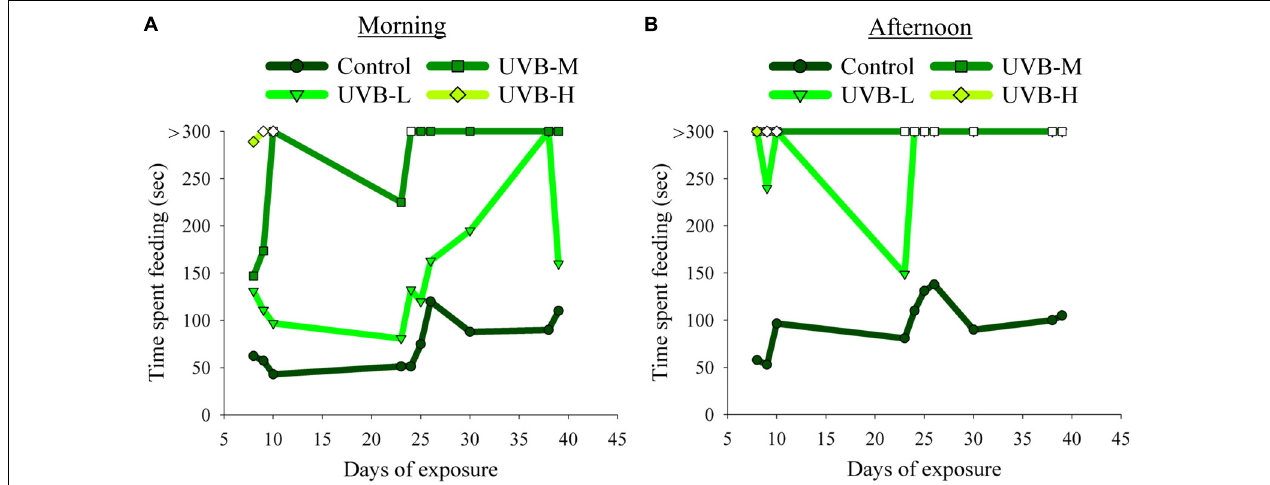
FIGURE 2 | Effect of UVB on the S. aurata feeding behavior observed during the experimental time: (A) morning (1 h before starting the UVB exposure) and (B) afternoon (4 h after starting the UVB exposure) meals. The time spent to consume the food (seconds, sec) was recorded on the 8th, 9th, 10th, 23rd, 24th, 25th, 26th, 30th, 38th, and 39th day of UVB exposure. Due to the humane endpoint for the UVB-H experimental group, the feeding behavior analysis in this treatment was done only on the 8th, 9th, and 10th days of exposure. Filled symbols indicate that fish consumed all the feed pellets; open symbols indicate that fish did not consume all the feed pellets. Fish were fed 3–5% of their body weight per day. The feed was provided twice a day in two equal meals, one in the morning (9 AM) and the other during the afternoon (between 2 and 3 PM).